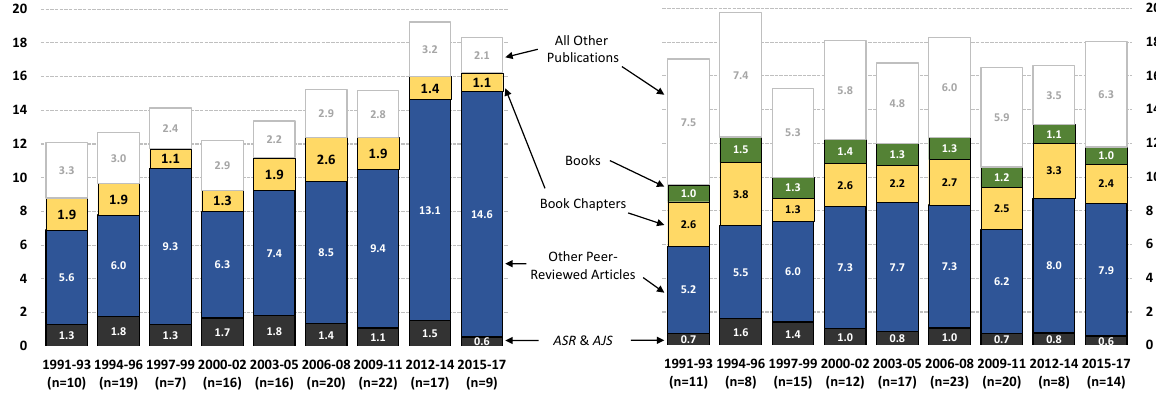
Figure 4: Mean number of publications among newly promoted associate professors by type, year, and whether they published a book (never [left] or one or more [right]).